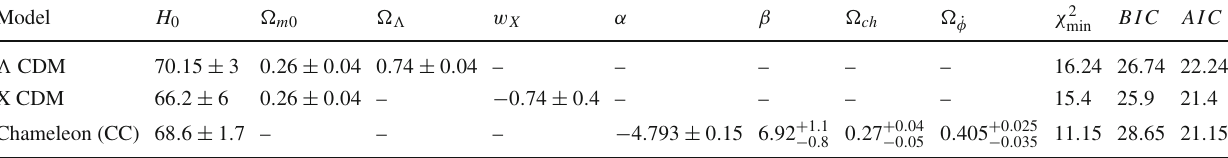
Table 4 Mean values of free parameters of various models with 1 σ error bar for 33 Hubble data Model